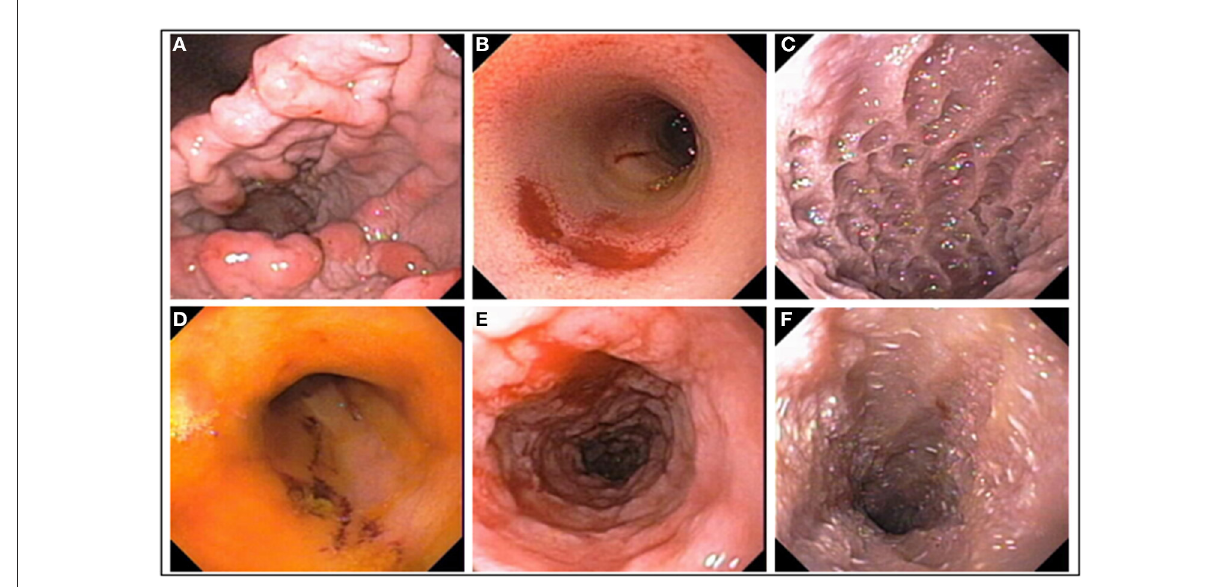
FIGURE4 Mucosal abnormalities used in calculation of the simple endoscopic score. (A) Gastric granularity, (B) duodenal erosions, (C) duodenal granularity, (D) ileal erosions, (E) colonic granularity, and (F) lymphangiectasia,